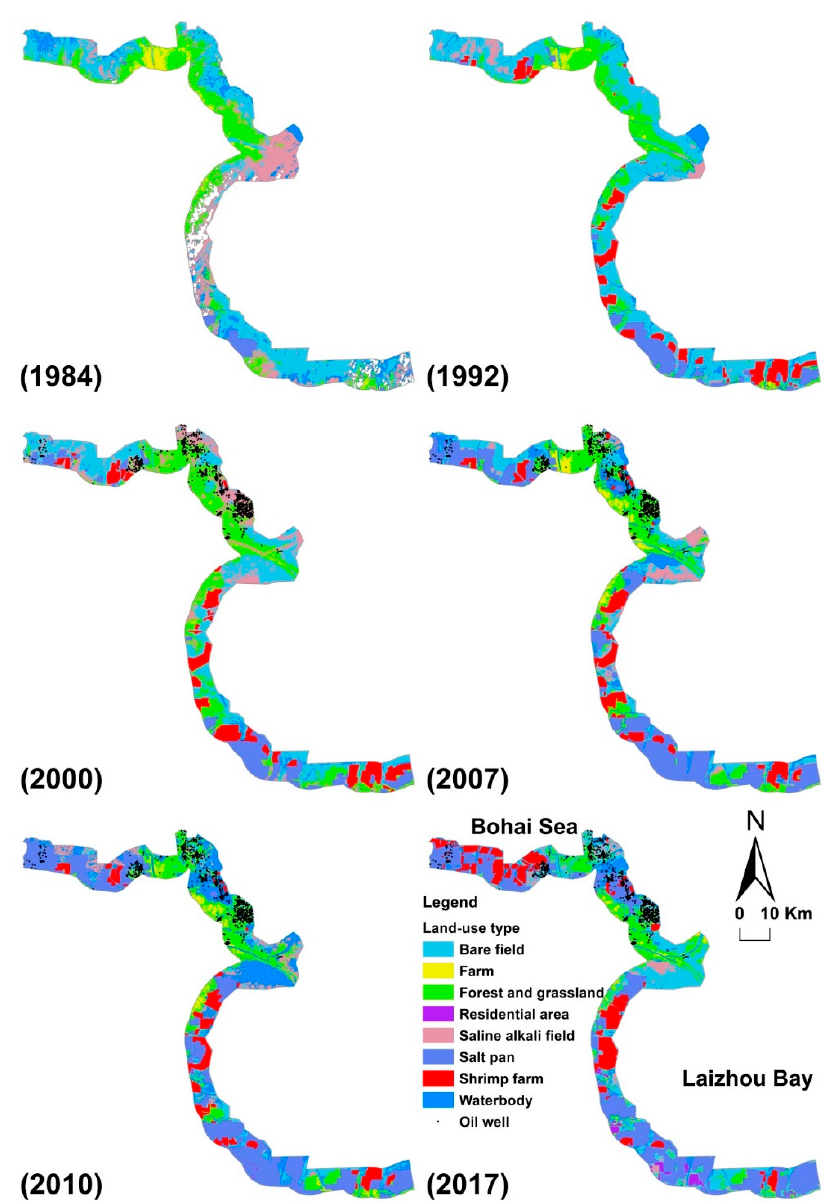
Figure 4. Land-use maps of the coastal area of the Yellow River Delta, China, derived from Landsat images from 1984, 1992, 2000, 2007, 2010, and 2017.